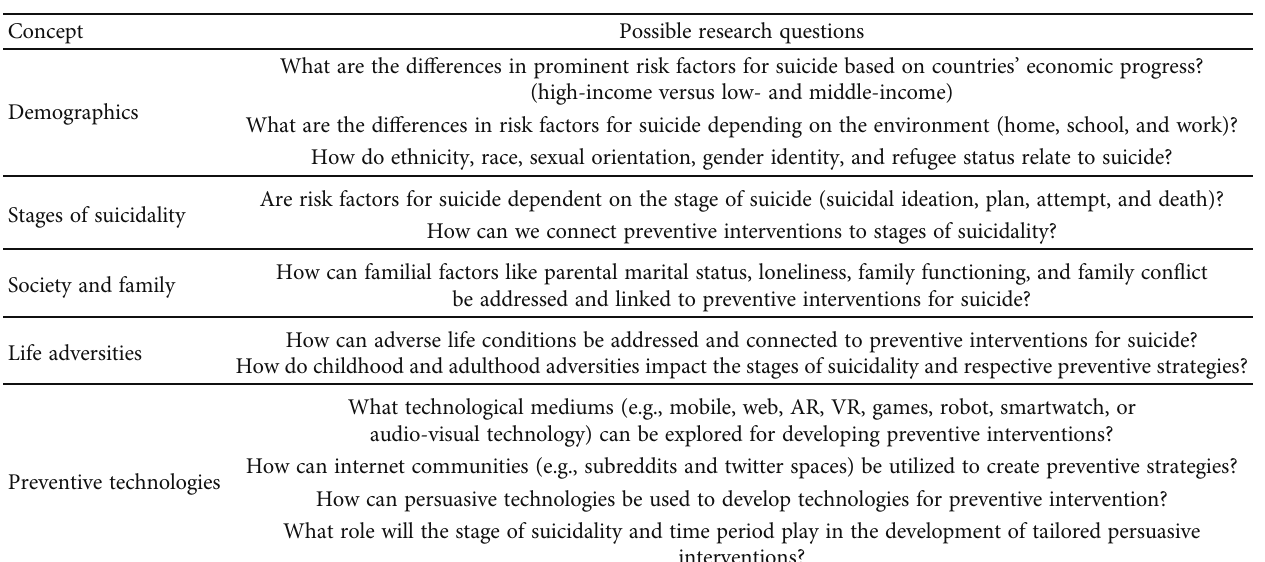
Table 4: Open research questions for research on suicidality and preventive